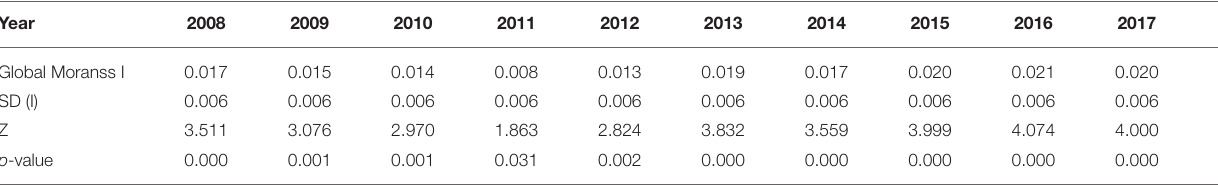
TABLE 4 | Global Moran index of explained variable (HDRIdoctor).